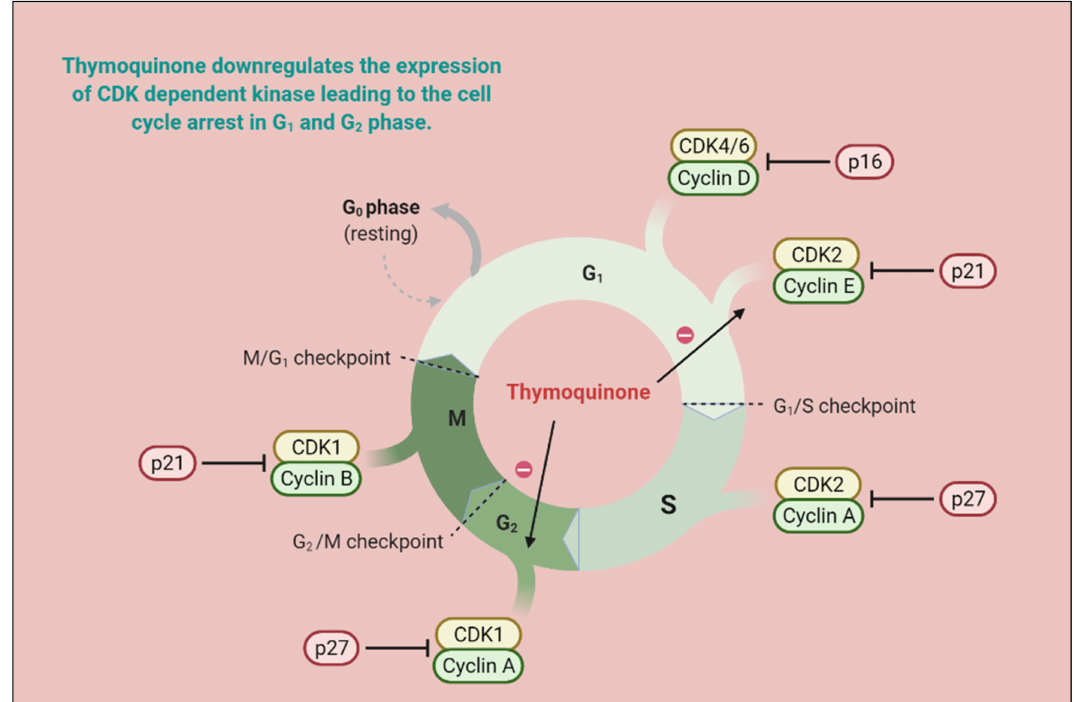
Figure 4. TQ prevents carcinogenic intermediate synthesis by inhibiting the G2/M phase of the cell cycle. It also inhibits ROS- mediated DNA damage to prevent tumorigenesis. TQ upregulates pro-apoptotic genes (p21 and p27) and downregulates the anti-apoptotic gene (Bcl-2), thereby arresting the G2/M phase of the cell cycle. (CDK—cyclin-dependent kinases; CYP—cytochrome P; TQ—Thymoquinone). Table 3. In vitro applications of thymoquinone in the treatment of cancer ( ↓ : decreases, ↑ : increase).